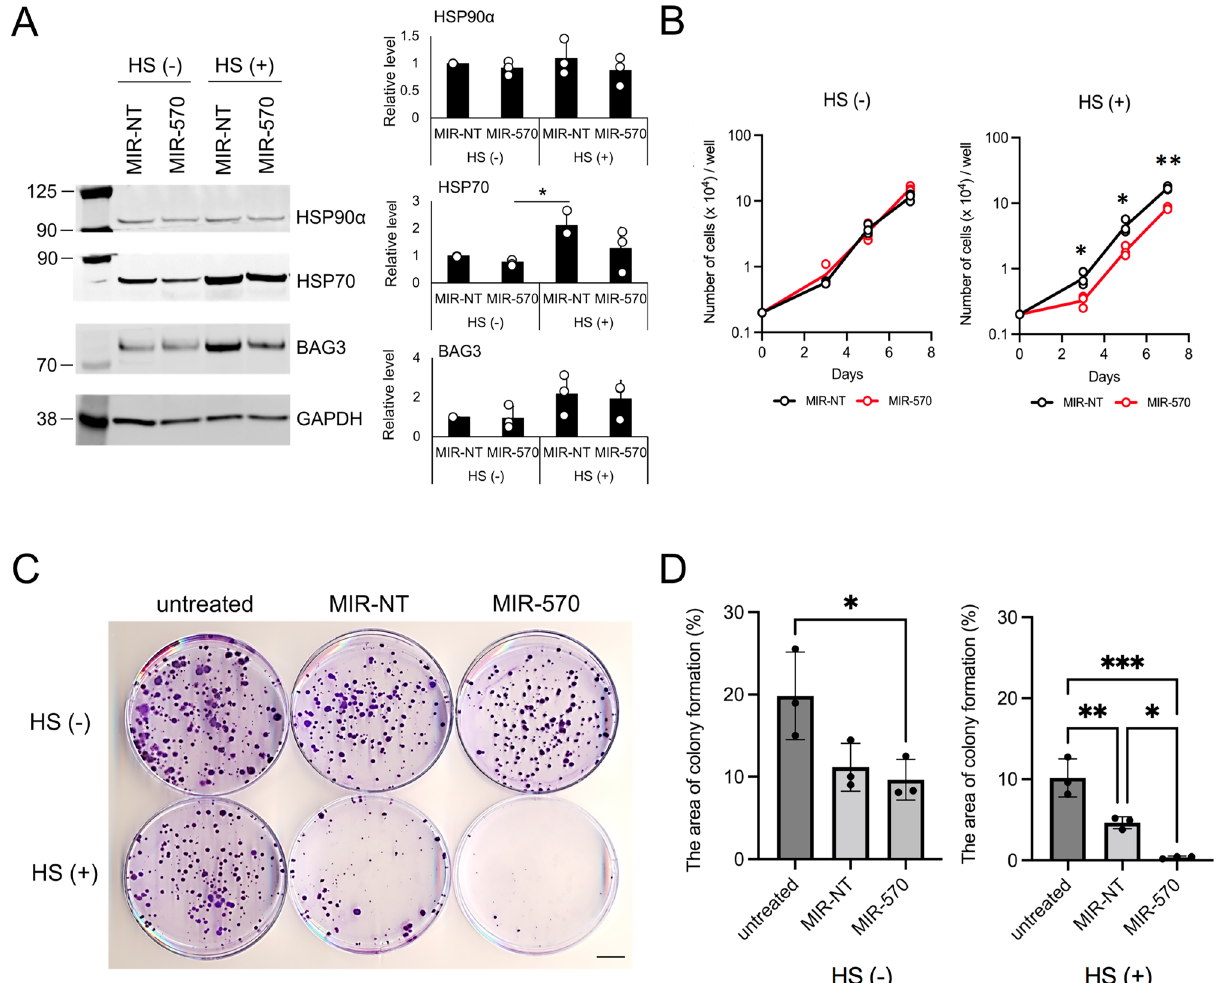
Figure 5. The role of miR-570 in cellular resistance to proteotoxic stress. ( A ) Western blot analysis of HSP90α, HSP70, BAG3 and GAPDH in HEK293T cells 72 h after transfection with miR-570 (50 nM) or MIR-NT (50 nM) and heat shock treatment. HS (−): untreated, HS (+): heat shock treatment. Quantitative analyses of western blot for HSP90α, HSP70 and BAG3 of three individual experiments and the individual data points are indicated by the open circles (n = 3; *p < 0.05, one-way ANOVA followed by post hoc Turkey’s test, error bars = SD). Levels of GAPDH expression was used as loading control. Molecular weight markers are indicated in kilodalton. Original blots are presented in Supplementary Fig. S7. ( B ) Growth curves of control non-targeting miRNA and mir-570 cells. Representative image of three individual experiments with three replicates (n = 3; *p < 0.05, **p < 0.01, Student’s t-test, error bars = SD). ( C ) Representative image of colony formation in untreated or heat shock treated HEK293T cells, control non-targeting miRNA and mir-570 cells stained with crystal violet. Scale bar, 1 cm. ( D ) Quantitative analyses of colony formation numbers. Percentage of colonies formed was calculated using ImageJ. Representative image of three individual experiments with three replicates (n = 3; *p < 0.05, **p < 0.01, ***p < 0.001, one-way ANOVA followed by post hoc Turkey’s test, error bars =